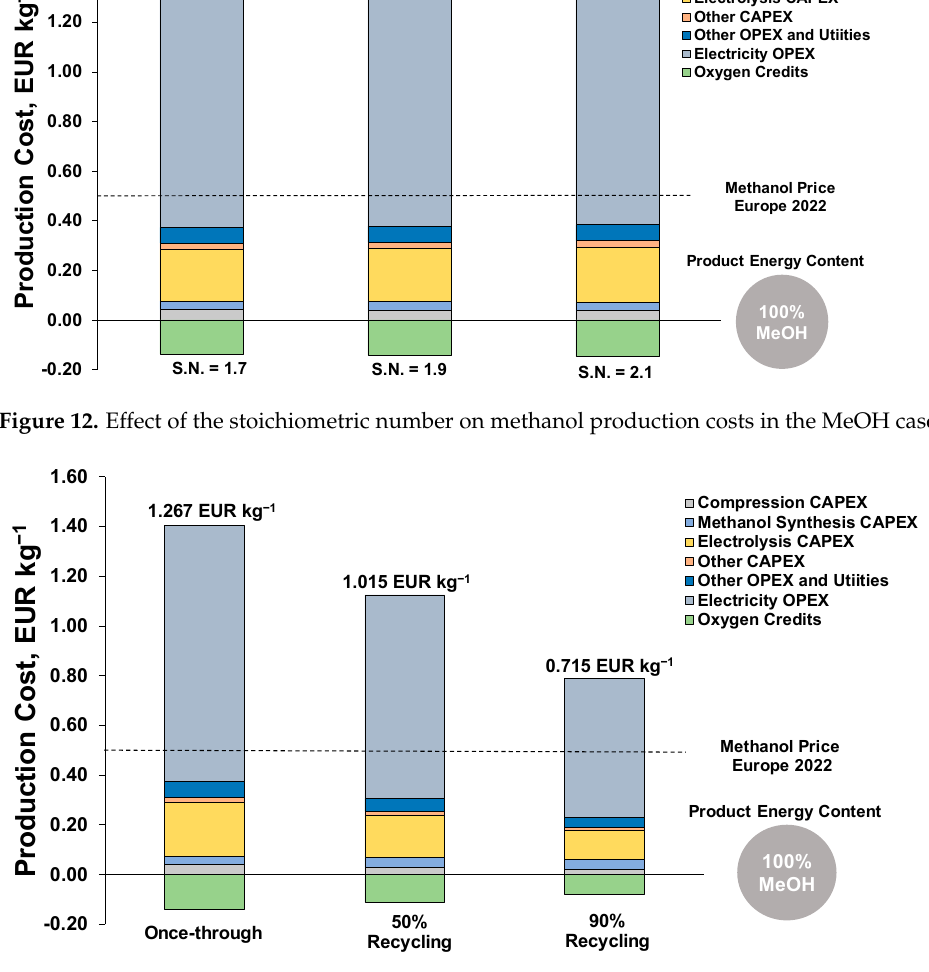
Figure 13. Effect of recycling on methanol production costs in the MeOH case.